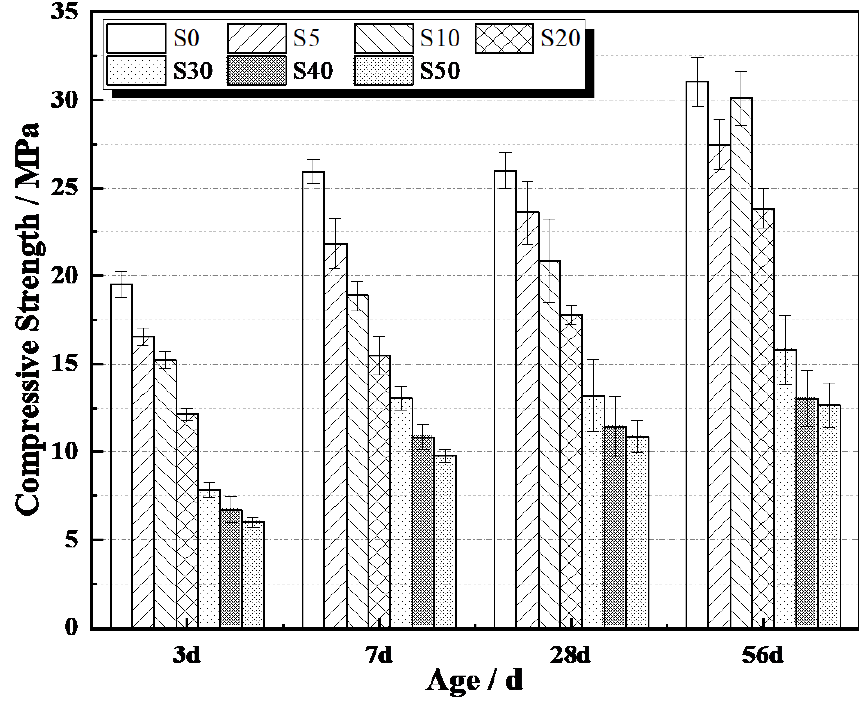
Figure 8. Compressive strength of AAS mortars .